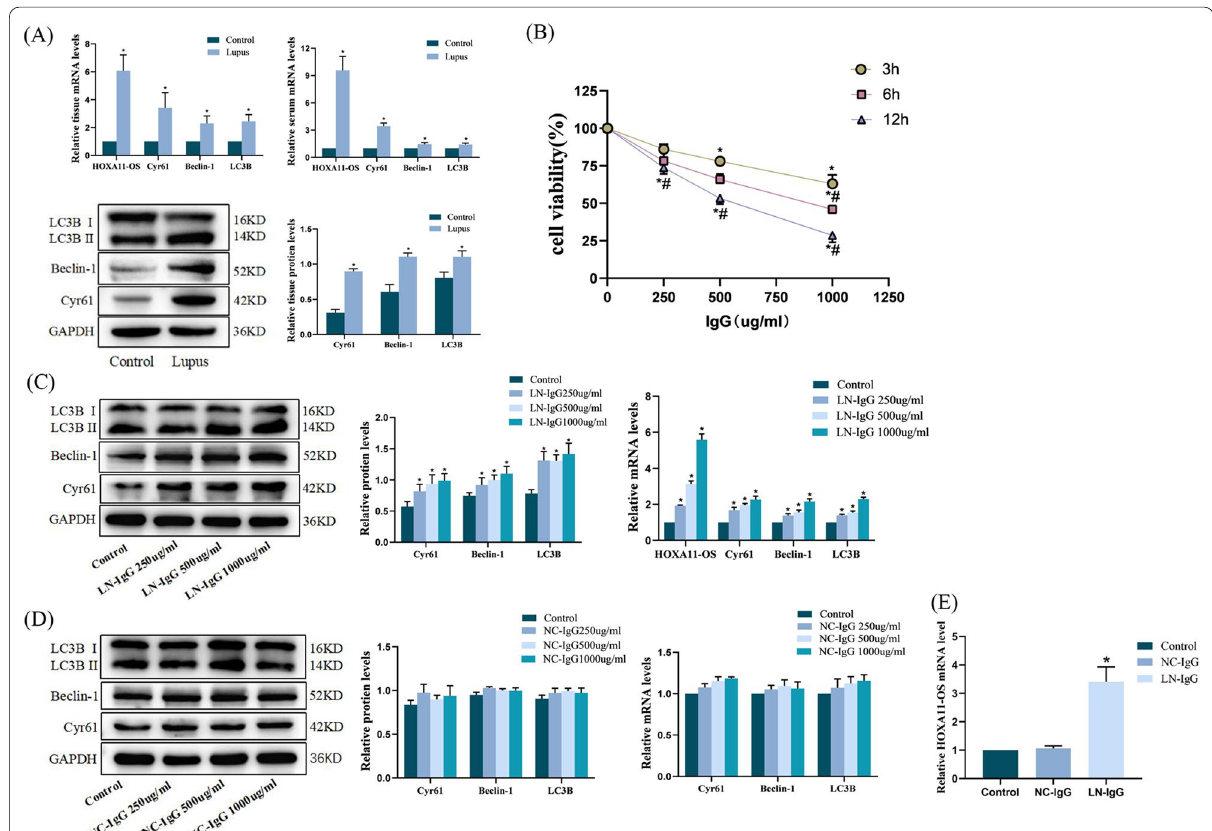
Fig. 1 HYPERLINK "sps:id::fig1||locator::gr1||MediaObject::0" HOXA11-OS, Cyr61, Beclin-1, and LC3B are highly expressed in kidney tissues, serum, and cell lines of LN. A Expression of HOXA11-OS, Cyr61, Beclin-1, and LC3B in the kidney tissue of lupus mice and serum of lupus patients as detected by qRT-PCR and western blotting. * P < 0.05 vs. control group. Data are presented as means standard deviation. B Podocytes induced by different ± concentrations of serum IgG (250, 500, or 1000 μg/mL) from lupus patients for 3, 6, and 12 h. Podocyte activity was detected by CCK-8. * P < 0.05 vs. 0 μg/mL; # P < 0.05 vs. 3 h. C Expression of HOXA11-OS, Cyr61, Beclin-1, and LC3B as detected by qRT-PCR and western blotting after podocytes were induced by different concentrations of IgG from lupus patients sera for 6 h. * P < 0.05 vs. control group. D Expression of Cyr61, Beclin-1, and LC3B as detected by qRT-PCR and western blotting after podocytes were induced by different concentrations of IgG from normal human serum for 6 h. E Expression of HOXA11-OS mRNA in control, NC-IgG (1000 μg/mL, 6 h) and LN-IgG (1000 μg/mL, 6 h) groups was detected by qRT-PCR. * P < 0.01 vs. control